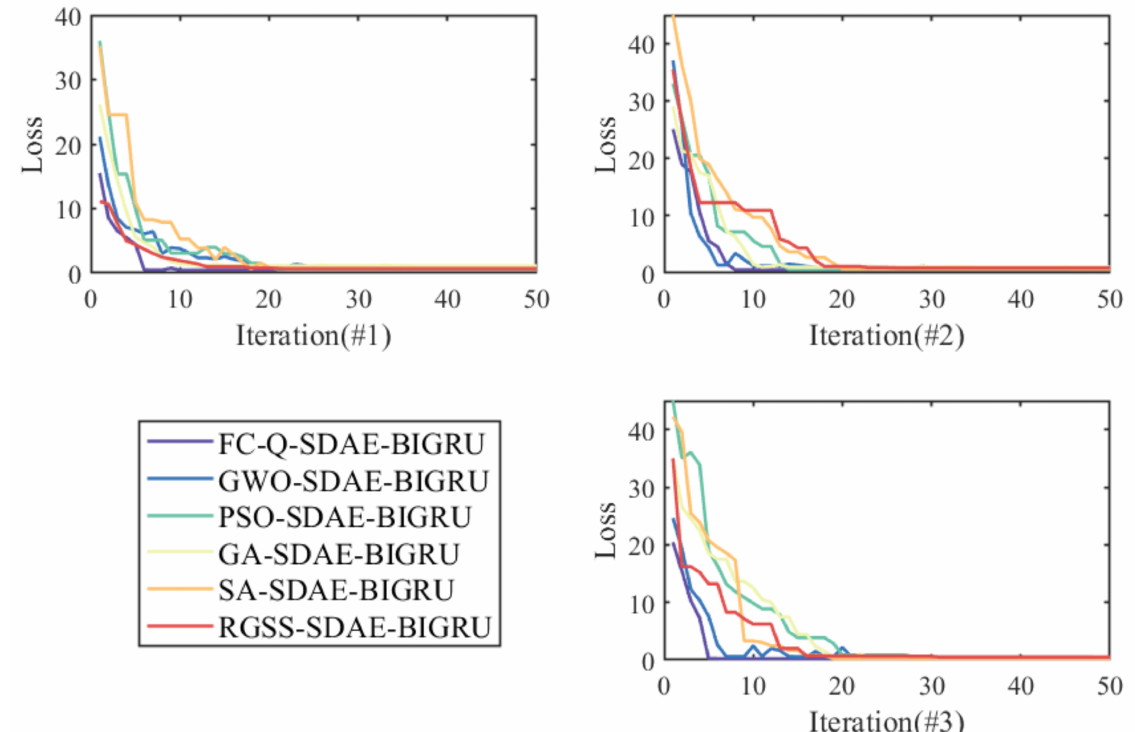
Figure 11. Values of Loss during the iterations of Q-learning, GWO, PSO, GA, SA, and RGSS in series #1, #2, and